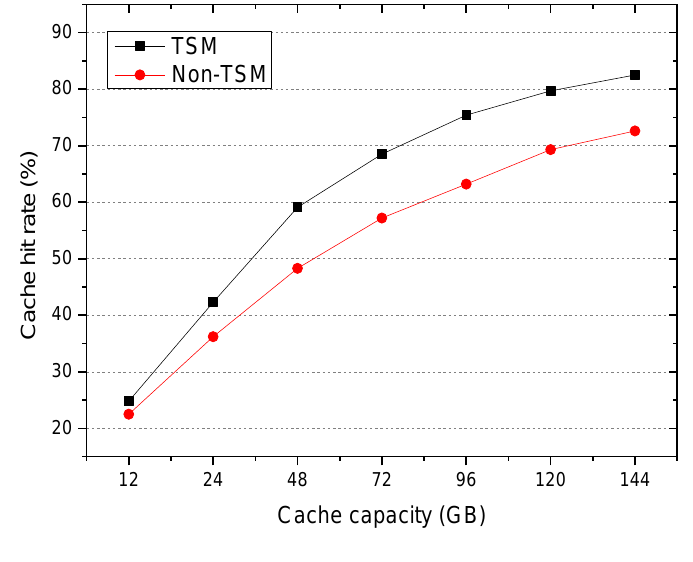
Figure 3. Cache hit ratio.